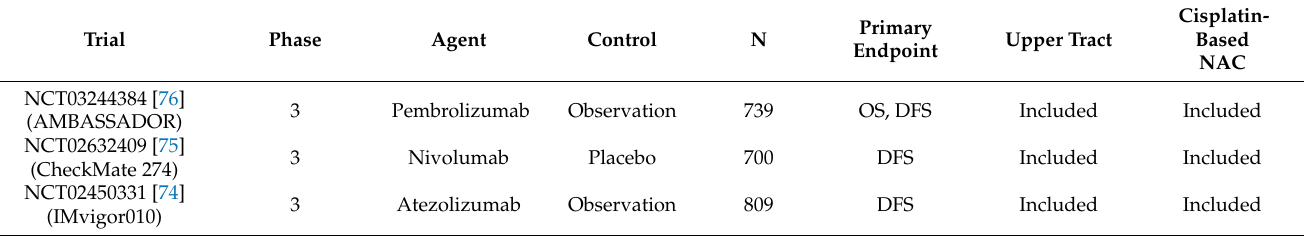
Table 5. Summary of phase 3 trials for adjuvant immunotherapy in muscle-invasive bladder cancer.